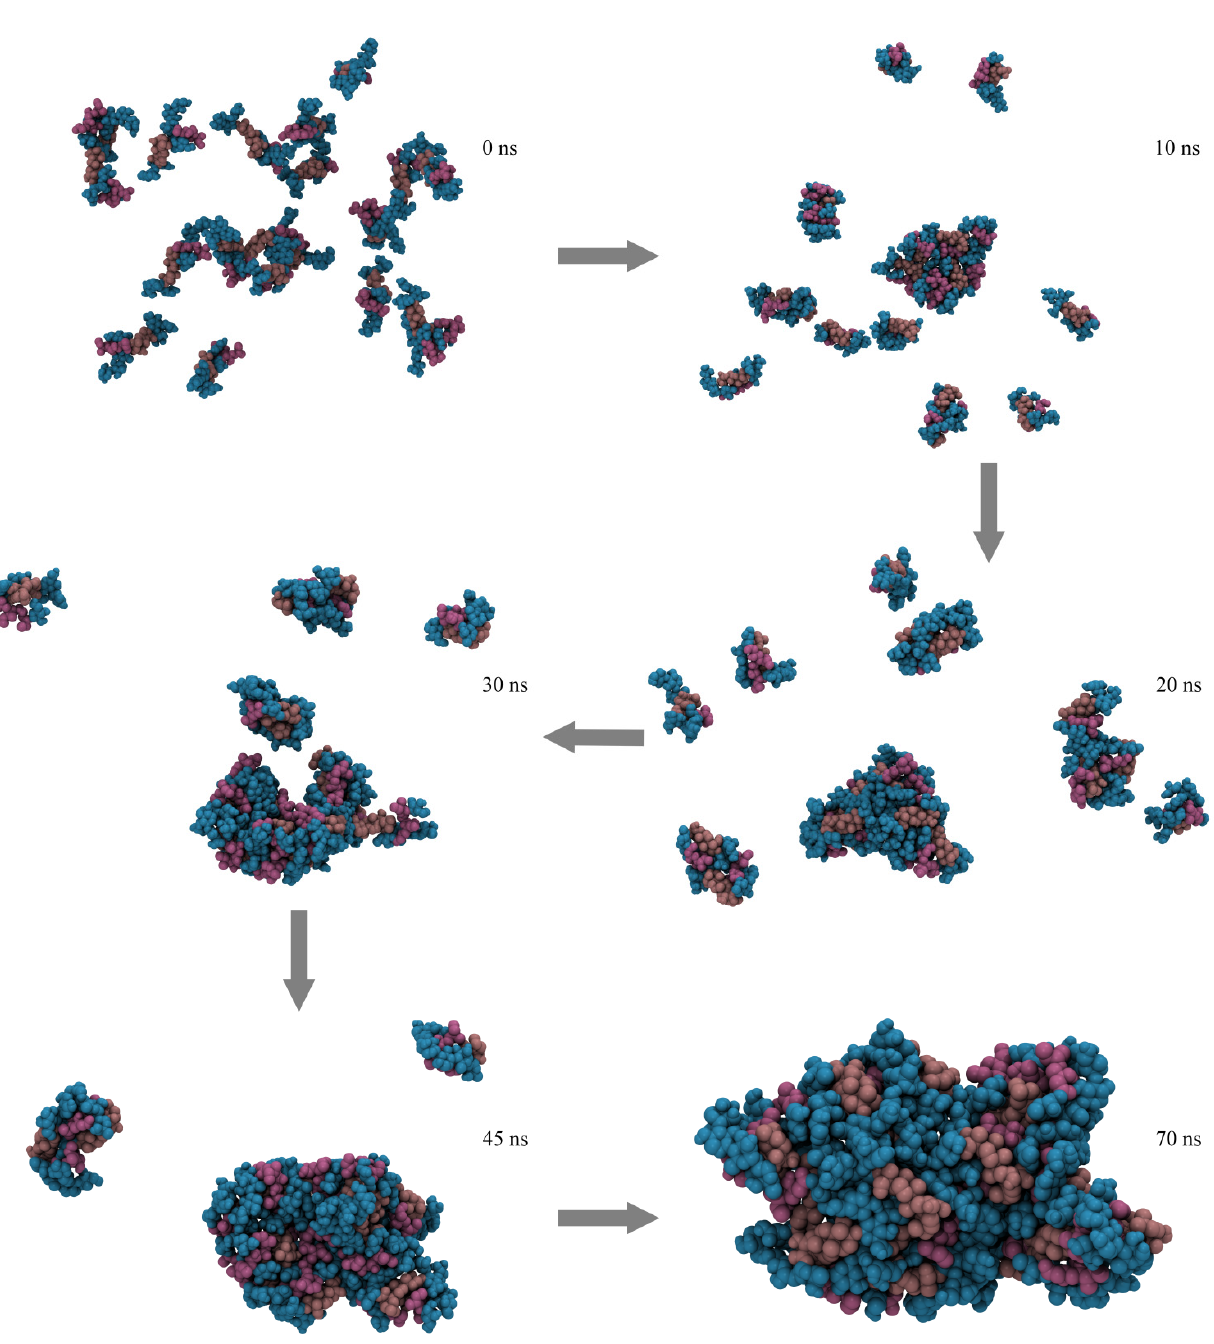
Figure 5. Assembly of a micelle composed by 20 molecules of QS-21 after a 0.1 μ s MD simulation. The carbohydrates are represented in blue, while QuillA and the acyl chains are represented in brown and purple,